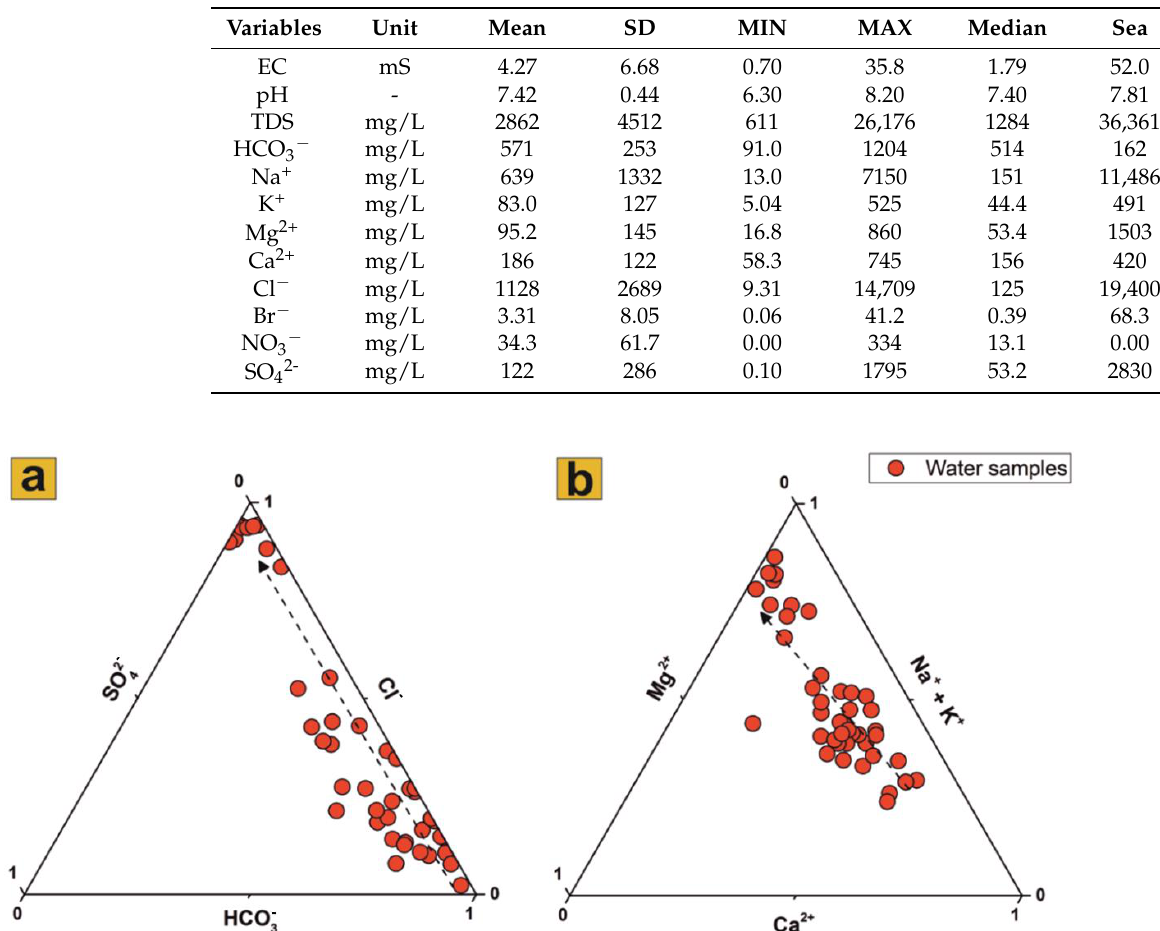
Figure 5. The major anions ( a ) and cations ( b ) ternary plots highlight the increasing trend in Cl − concentration, followed by alkali ions and Mg 2+ concentrations.